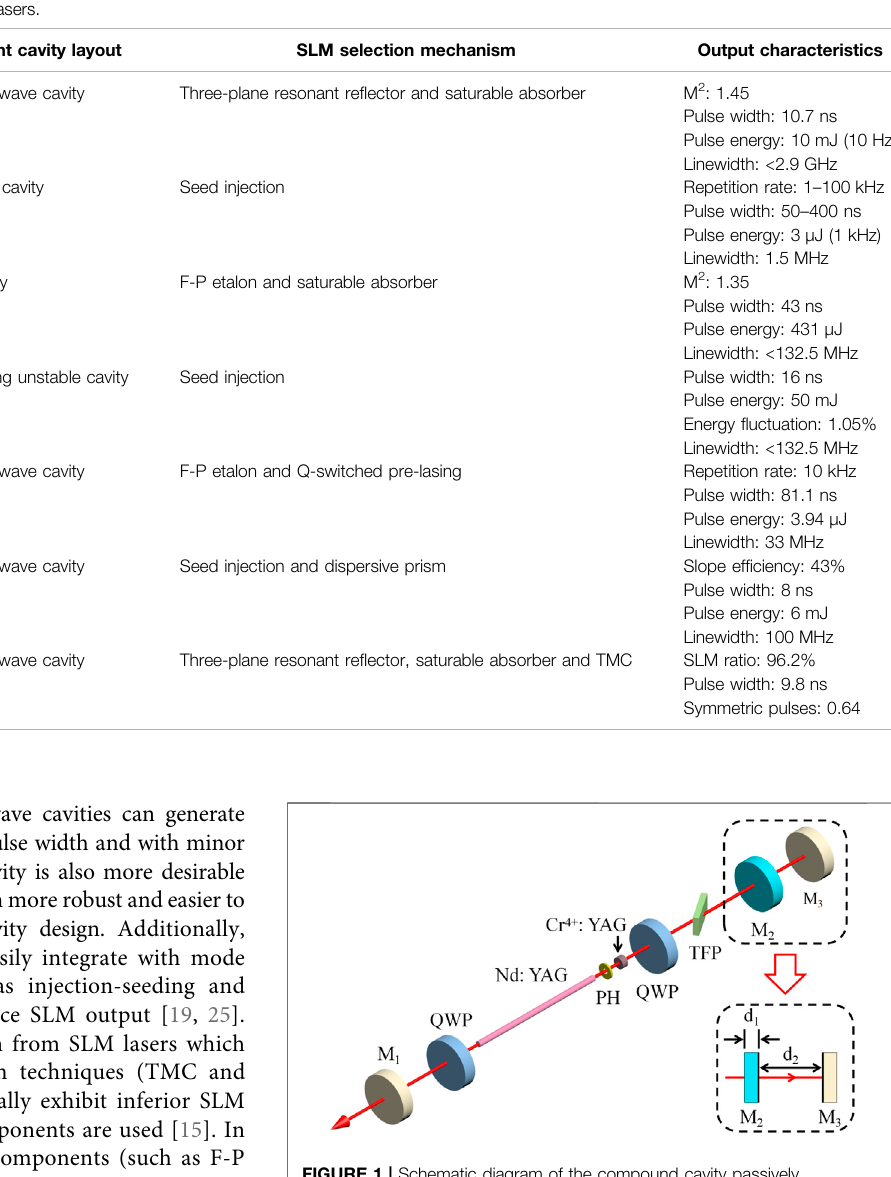
FIGURE 1 | Schematic diagram of the compound cavity passively Q-switched single-longitudinal-mode diode-pumped laser. QWP, quarter- wave plate; PH, pinhole; TFP, thin- fi lm polarizer. (Illustration: resonant mirror frequency